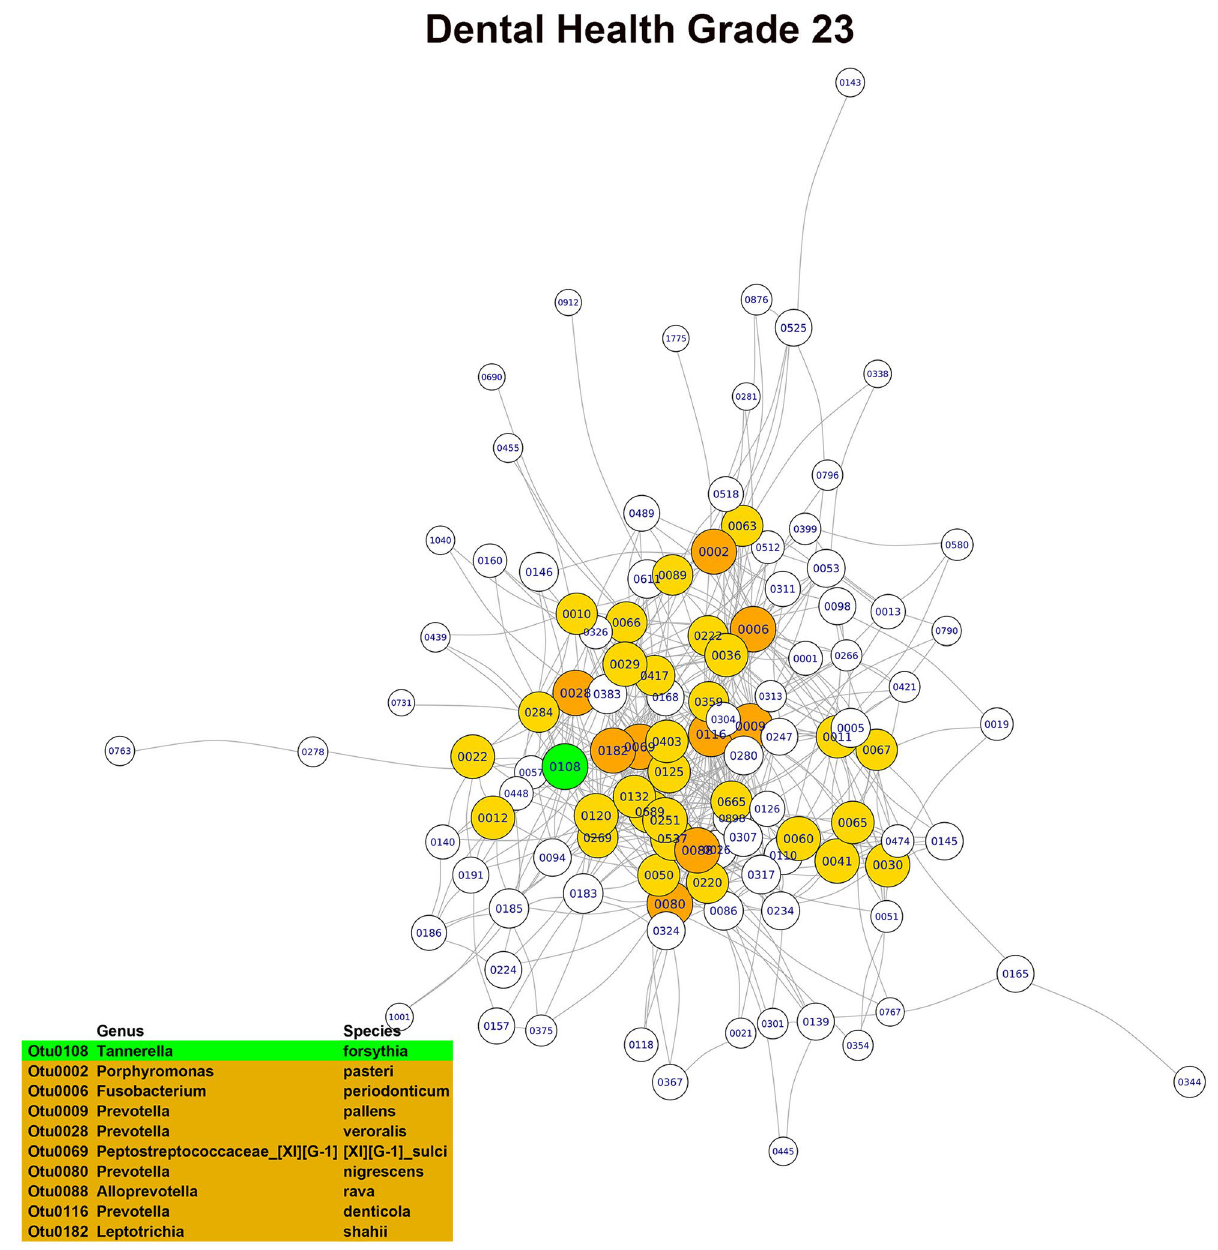
Figure 5. Main module of the co-occurrence network associated with grade 0 of the dental health subscale (node = 113; degree = 1444) (graphic made using the igraph package, version